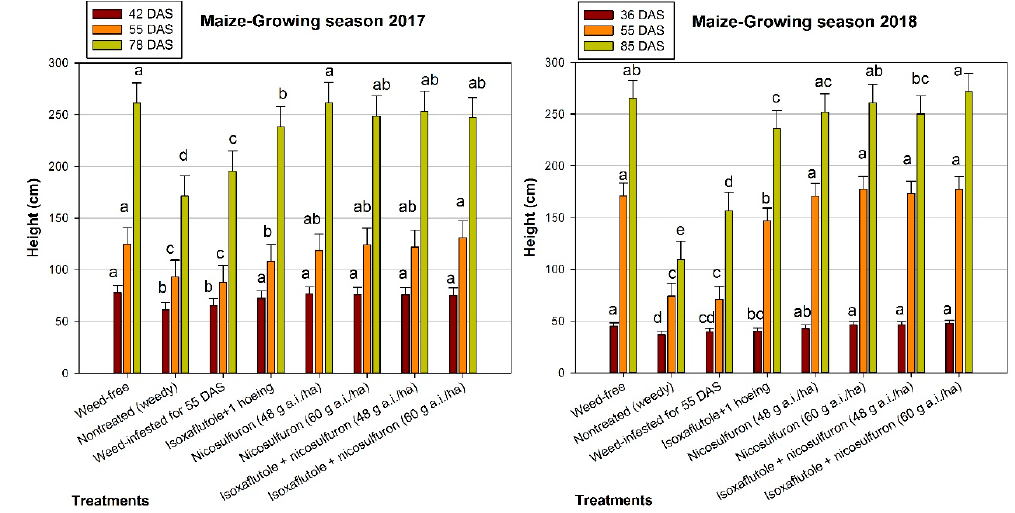
Figure 3. Maize height as affected by the various treatments at 36–42 days after sowing (DAS), 55 DAS, and 78–85 DAS, in 2017 and 2018 (Velestino, Greece). For each measurement, bars followed by different letters indicate significant differences according to Fisher’s LSD test ( p ≤ 0.05). Error bars indicate the LSD 5% values.